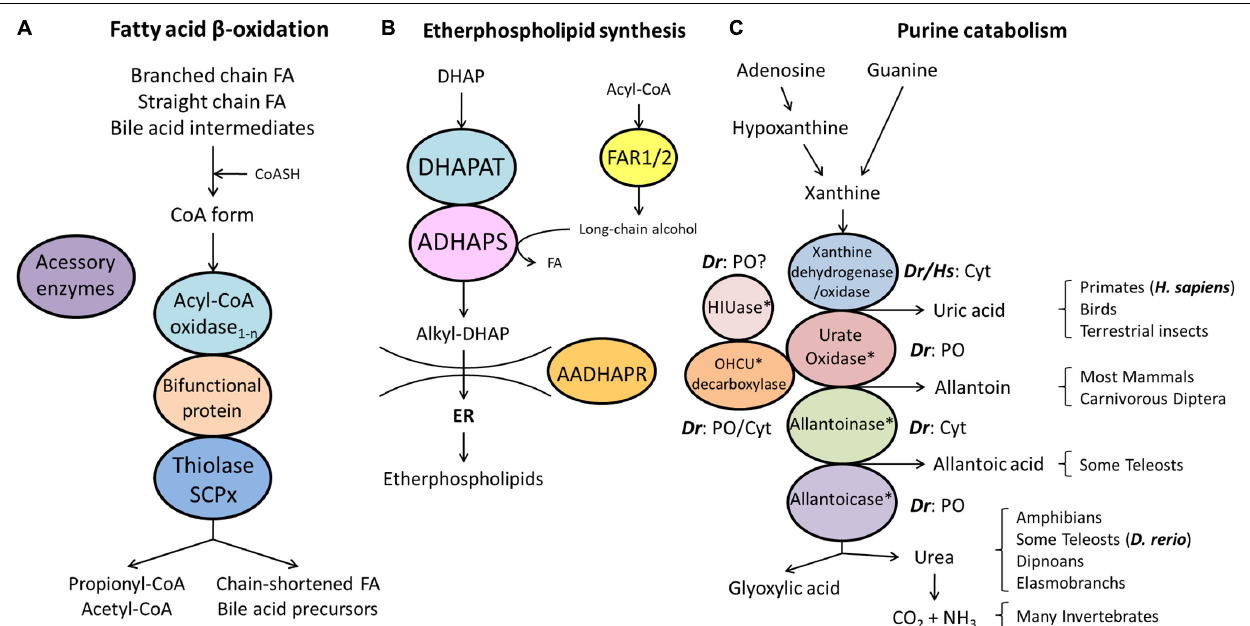
FIGURE 3 | Schematic representation of the pathways of fatty acid β -oxidation (A) , ether phospholipid synthesis (B) and purine catabolism (C) in peroxisomes. (A) Peroxisomes degrade fatty acids in four consecutive steps: (1) oxidation, (2) hydration, (3) dehydrogenation, and (4) thiolytic cleavage. Step 1 is performed by multiple acyl-CoA oxidases (1-n) with different substrate specificities. Steps 2 and 3 involve two bifunctional proteins (L-BP, D-BP) harbouring both enoyl-CoA hydratase and 3-hydroxy-acyl-CoA dehydrogenase activity. Step 4 requires different thiolases (e.g., ACAA1, SCPx). Peroxisomes have acquired a set of accessory enzymes (e.g., for fatty acid α -oxidation) to transform the acyl-CoA esters of those fatty acids (FA), which cannot directly enter the β -oxidation pathway (e.g., phytanic acid) (see text for details). (B) The first three steps of ether phospholipid synthesis take place in peroxisomes; synthesis continues in the endoplasmic reticulum (ER). (C) Enzymes involved in purine catabolism in different vertebrate groups and their excretion products. Note that the cellular localisation (cytosolic, peroxisomal) of these enzymes varies amongst vertebrate species. Xanthine oxidase is cytosolic (Cyt) in H. sapiens ( Hs ) and D. rerio ( Dr ). Urate oxidase, HIUase, OHCU decarboxylase, and allantoicase are supposed to localise to peroxisomes (PO) in D. rerio , but are absent in H. sapiens (asterisks) (see also Table 1 ). Allantoinase is cytosolic in D. rerio , but absent in H. sapiens (asterisks). AADHAPR, alkyl-dihydroxyacetone phosphate reductase; ADHAPS, alkyl-dihydroxyacetone phosphate synthase; DHAP, dihydroxyacetone phosphate; DHAPAT, dihydroxyacetone phosphate acyltransferase; FAR1/2, fatty acyl-CoA reductases 1/2; HIUase, 5-hydroxyisourate hydrolase; OHCU decarboxylase, 2-oxo-4-hydroxy-4-carboxy-5-ureidoimidazoline decarboxylase (adapted from Islinger et al.,